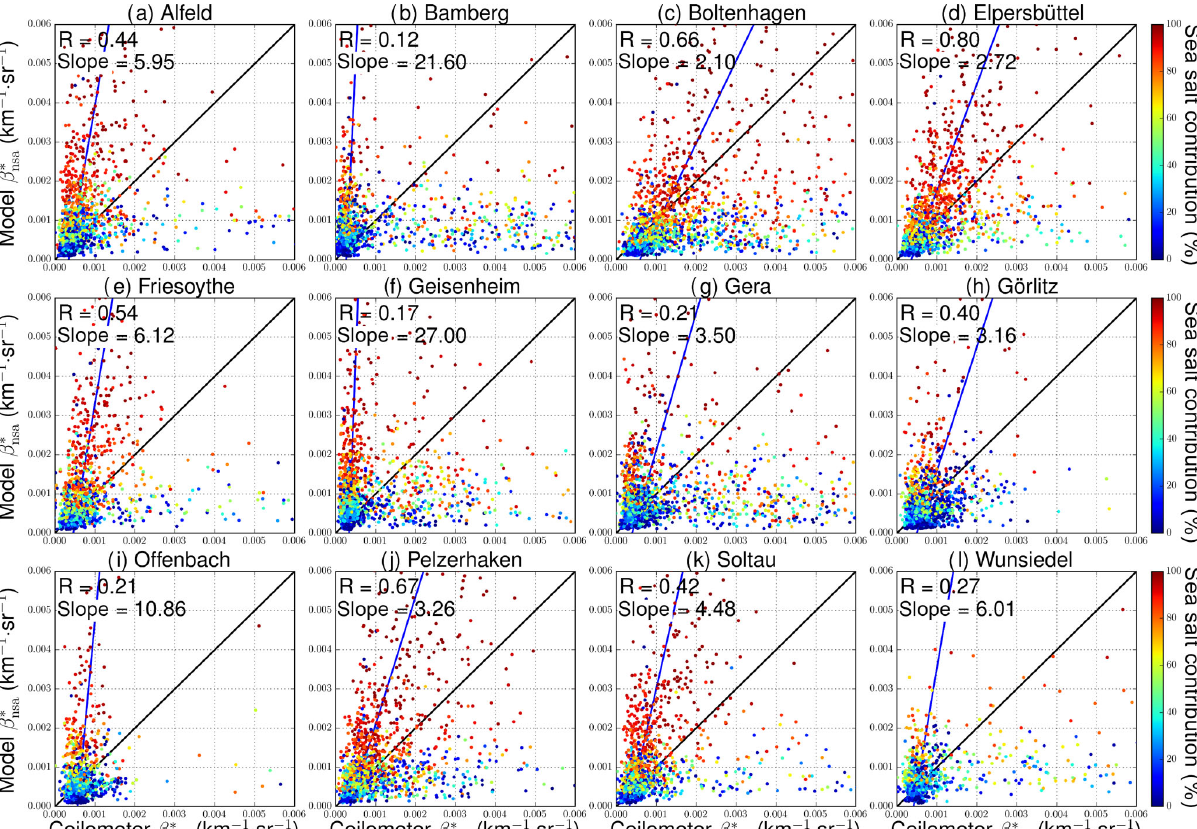
Figure 5. Scatter plots of ceilometer-derived and modeled β ∗ ns for the 12 sites listed in Table 2. The color code represents the relative contribution of sea salt to β ∗ ns . The blue curve indicates the total least squares regression line of the data points with at least 120 ceilometer profiles, while the black line represents the 1 : 1